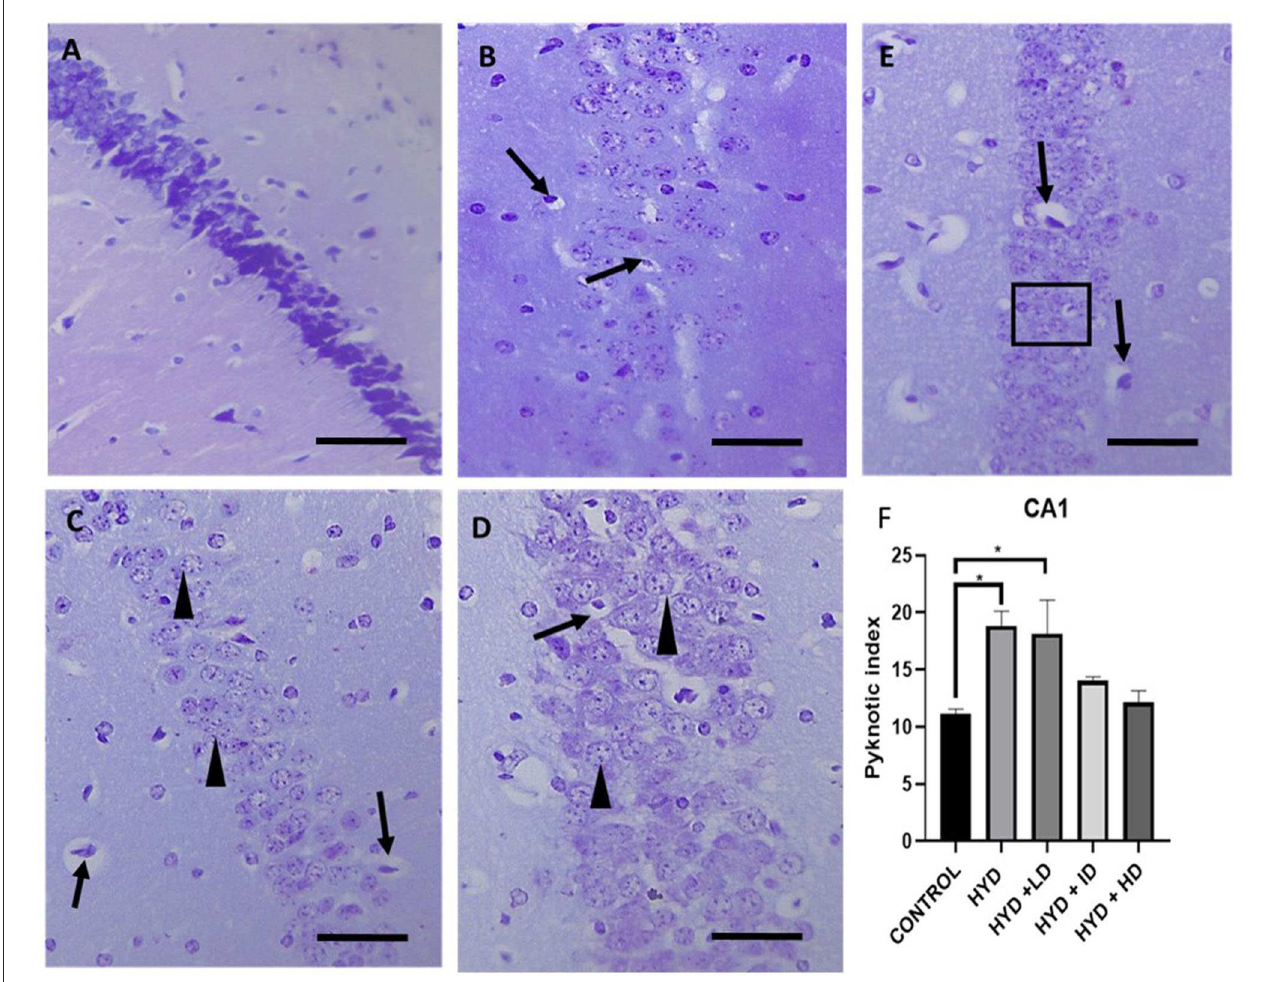
FIGURE4 Photomicrograph of Cresyl stained CA1 region of the hippocampus of control and experimental mice. (A) Control, (B) hydrocephalus only (HYD), (C) hydrocephalus + low dose vanadium (HYD + LD), (D) hydrocephalus + intermediate dose vanadium (HYD + ID), (E) hydrocephalus + high dose vanadium (HYD + HD). Note the cells of the control compared to those of the other groups, also the cells of the vanadium treated groups show cell recovery (as indicated by the normal cells) and less pyknotic cells than the hydrocephalus only group, and (F) bar chart showing the pyknotic index of the CA1 region of the hippocampus of the control and experimental groups. The pyknotic index of the hydrocephalic group and low dose vanadium treated group were significantly higher compared to that of the control [arrows, pyknotic neurons; arrowheads and inserted box in (E) , normal neurons; Scale bar, 4 µ